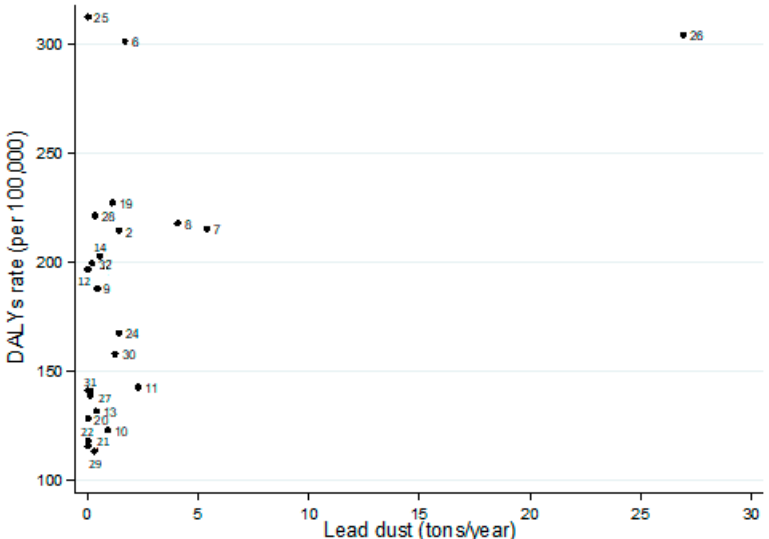
Figure 3. Mean environmental exposure to lead dust (tons/year) and Disability-Adjusted Life-Years (DALYs) rate (per 100,000) due to tracheal, bronchus, and lung cancer in both genders, Mexico 2019. Note: (a) Spearman’s rank correlation coefficient (rho) was: 0.48 ( 𝑝 = 0.017); (b) 2, Baja California; 4,